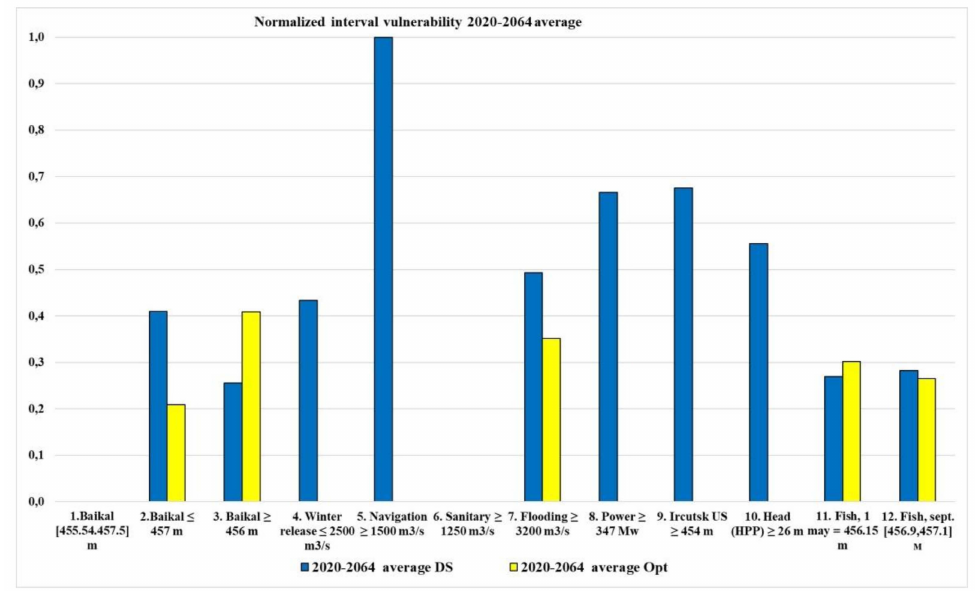
Figure 22. Normalized vulnerability when WRC use DS and optimization for the time series 2020– 2064